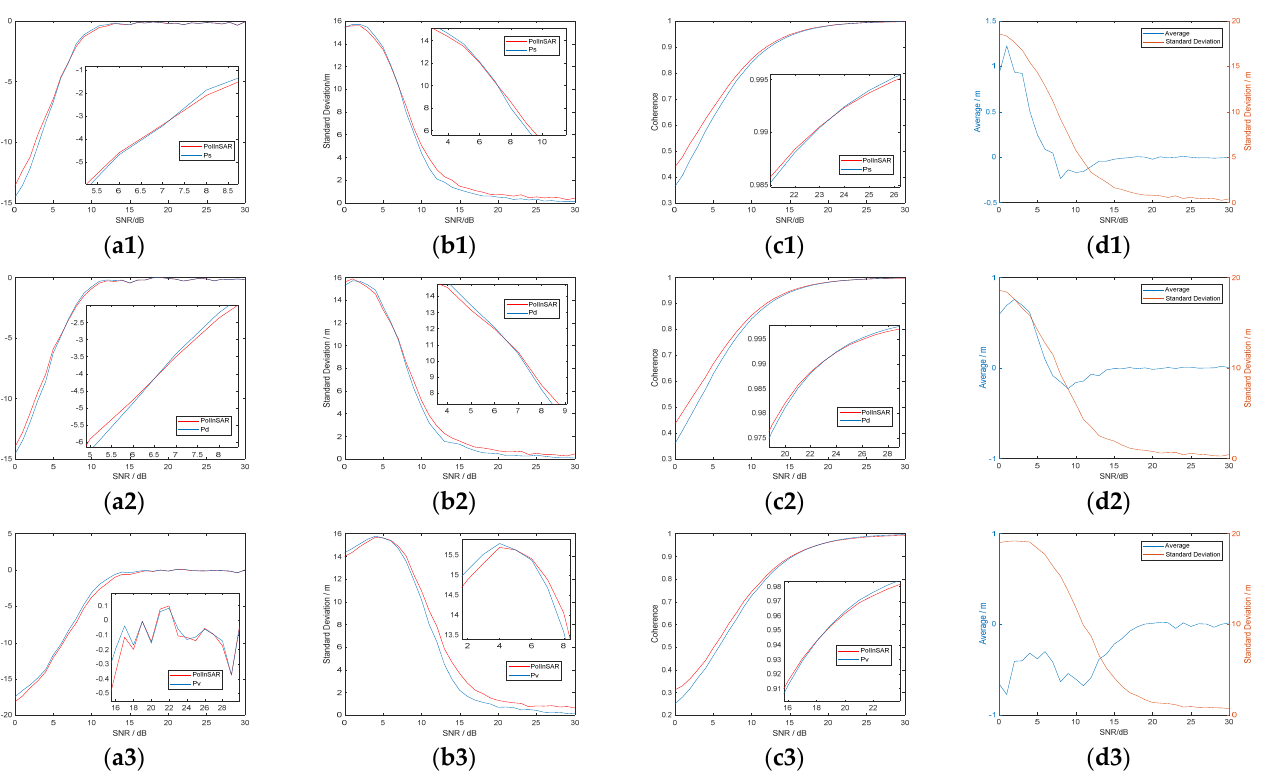
Figure A2. Simulation results of one scattering mechanism. ( a1 – a3 ) Mean error of height. ( b1 – b3 ) Standard deviation of height. ( c1 – c3 ) Coherence. ( d1 – d3 ) Average and standard deviation of height difference between PolInSAR and the scattering mechanism. The three rows respectively correspond to results of single scattering, double scattering of 0 degrees, and double scattering of 45 degrees.